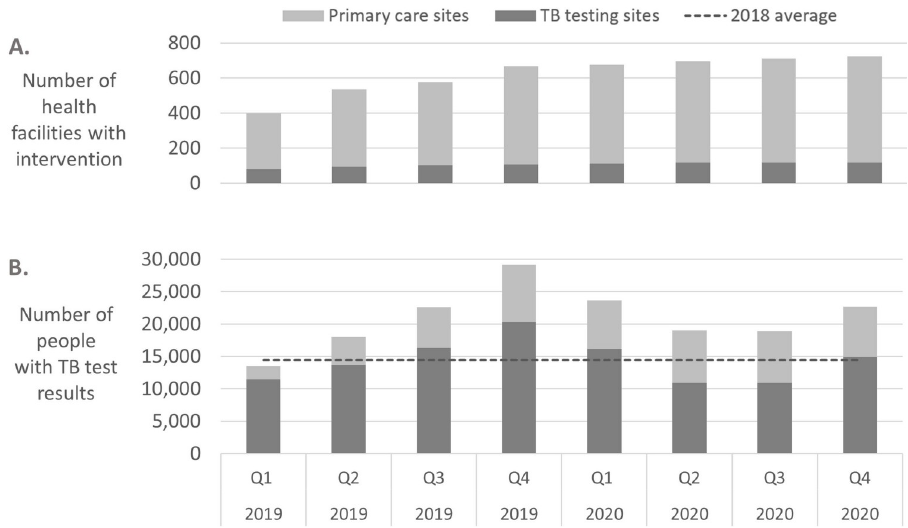
Fig 2. Number of intervention sites and numbers of people tested for TB during the intervention, by quarter. A) Number of TB testing sites (dark grey) and primary care sites (light grey) included in the intervention from Q1 2019 to Q4 2020 as the intervention scaled up. B) Number of people with TB tests results at the 725 intervention sites, from Q1 2019 to Q4 2020; people with TB tests results attending TB testing sites (dark grey) and attending primary care sites with specimens referred for testing at TB testing sites (light grey). The average number of people with TB tests each quarter in 2018, the year prior to the intervention, is shown as a dotted line.